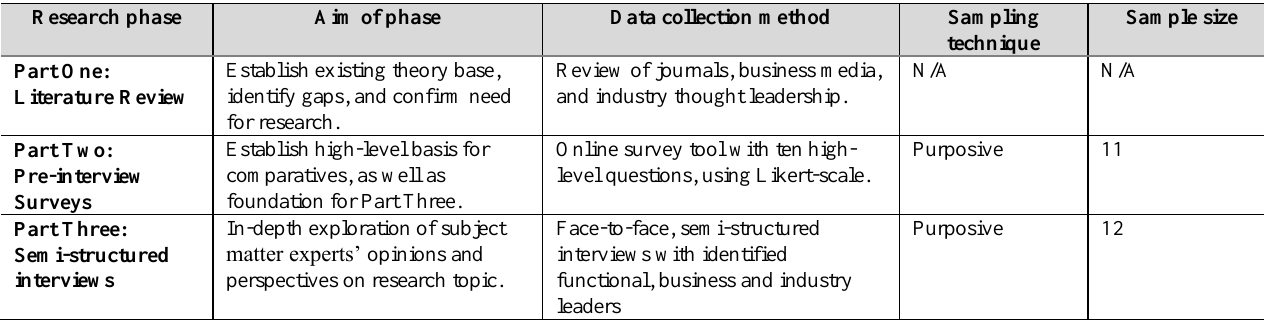
Table 1: Research phase and sampling information Research